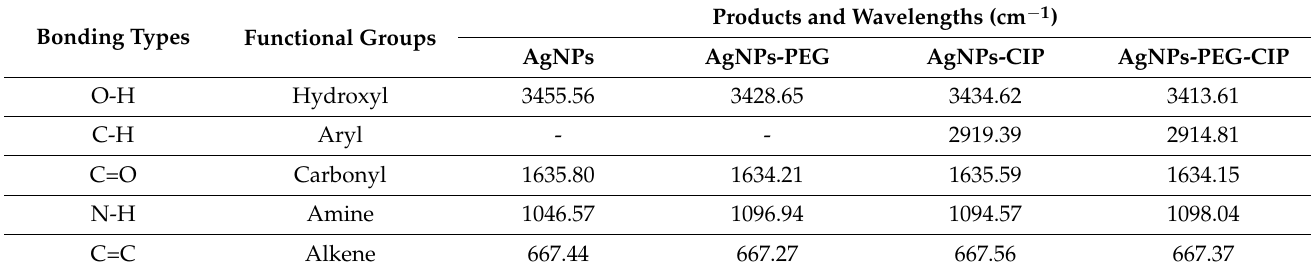
Figure 6. Fourier-transform infrared (FT-IR) spectra of AgNPs and their conjugates. Table 1. Functional groups in AgNPs and their PEG and CIP nano-conjugates.